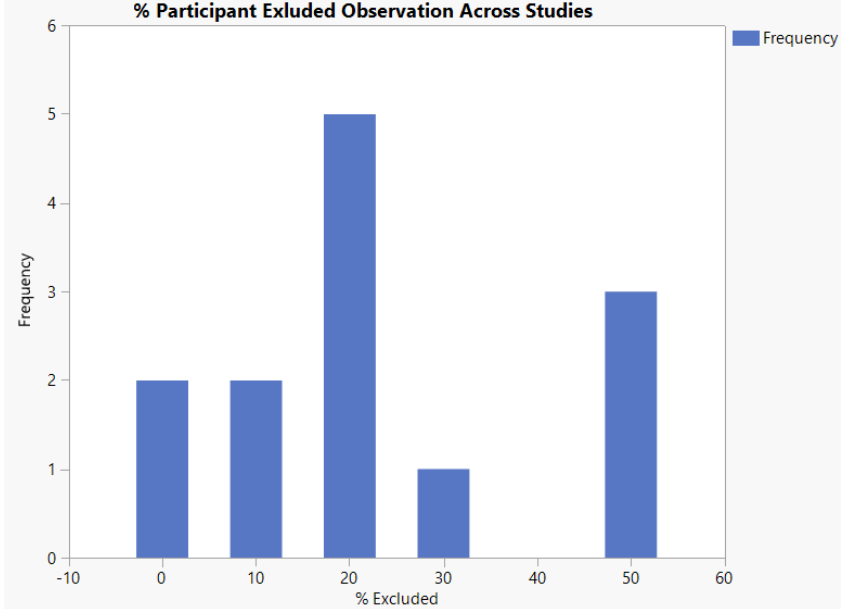
Figure 8. Percentage of participants excluded across 11 studies.